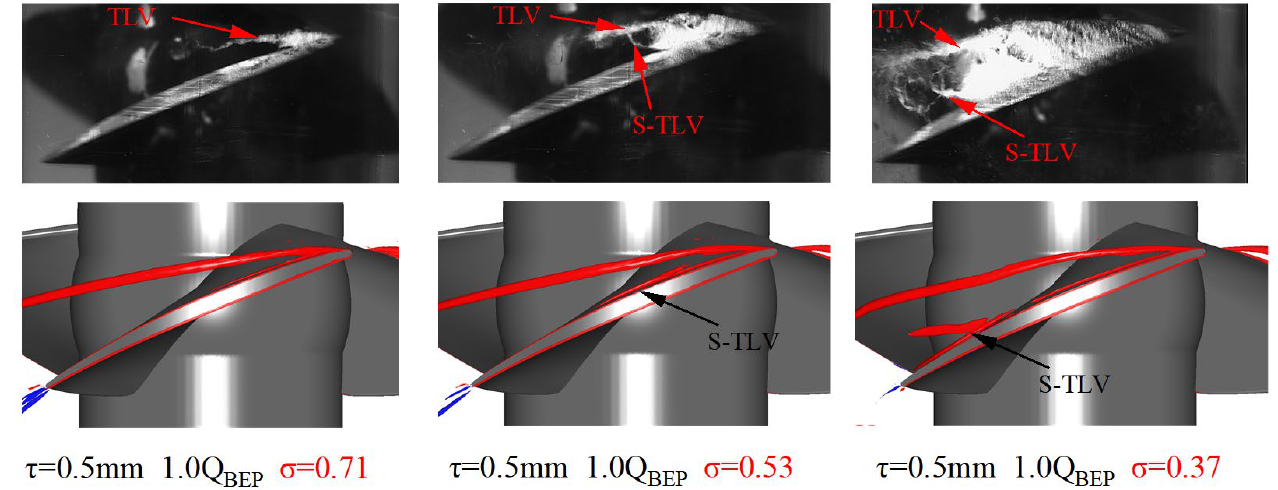
Figure 22. Cavitation images and vortex isosurface (Liutex R = 1000, Red—circumferential vortex, Blue—axial vortex) under different cavitation numbers.